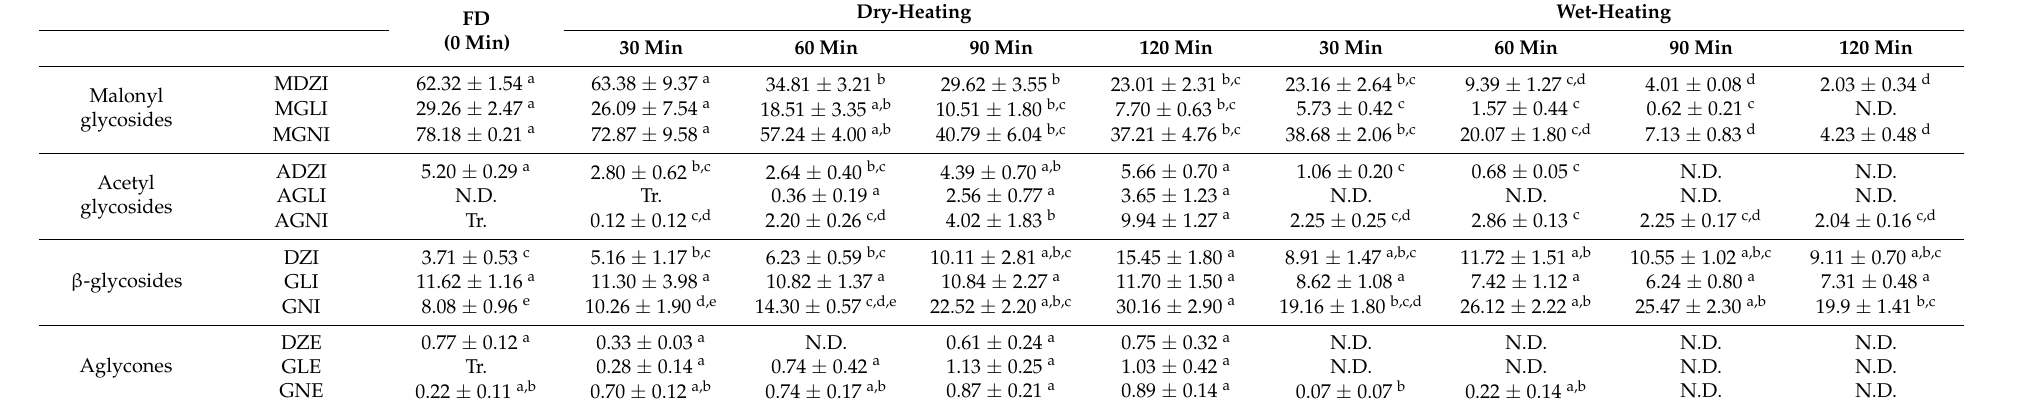
Table 2. Isoflavone content (mg/100 g DW) in immature soybeans during thermal processing.